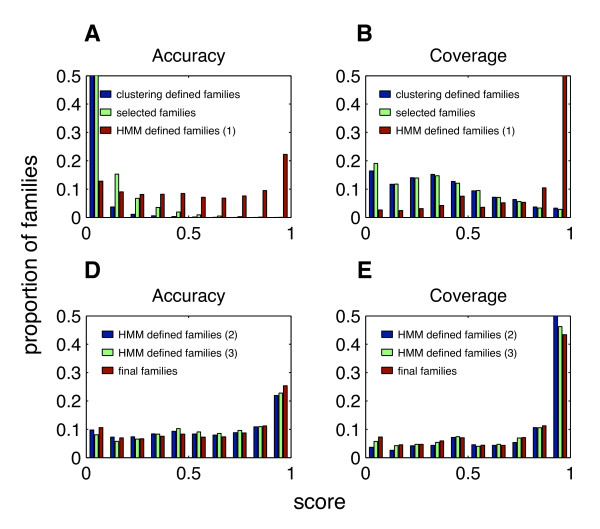
Performance along the EVEREST process generating release 1 with respect to Pfam. A and B: Blue bars – domain families defined in the clustering process of step 5 in the first iteration; green bars – selected domain families chosen in step 6 in the first iteration; red bars – domain families defined by the HMMs of step 7 in the first iteration. C and D: Blue bars – domain families defined by the HMMs of step 7 in the second iteration; green bars – domain families defined by the HMMs of step 7 in the third iteration; red bars – domain families defined by voting of sets of the HMMs of step 7 in the first iteration. Coverage shown is of hetero Pfam families. See sections Evaluation of Classification and Evaluating a Suggested Domain Family for further details.